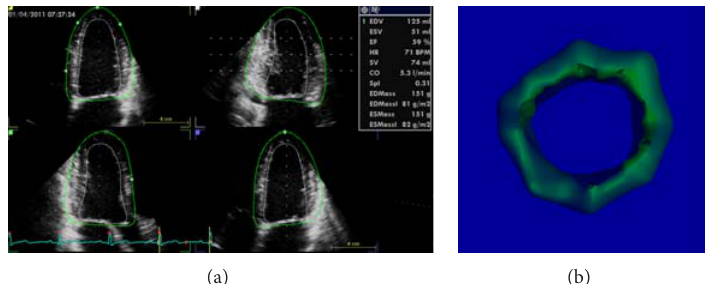
Figure 13: Left ventricular mass measurement using three-dimensional echocardiography. Using automated or semiautomated endocardial and epicardial boundary detection endocardial and epicardial volumes are measured (a). By subtracting the left ventricular cavity volume from the epicardial volume, the volume of myocardium is obtained (b). Left ventricular mass is calculated by multiplying myocardial volume by its specific gravity (1.05 g/cm 3 ).